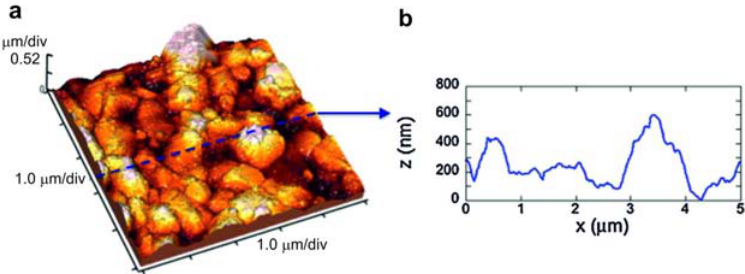
Figure 8. ( a ) 5 µm × 5 µm AFM image of the alumina substrate; ( b ) 5 µm line-scan profile measured from image (a). Reprinted from [46] with permission. Copyright (2013) Elsevier